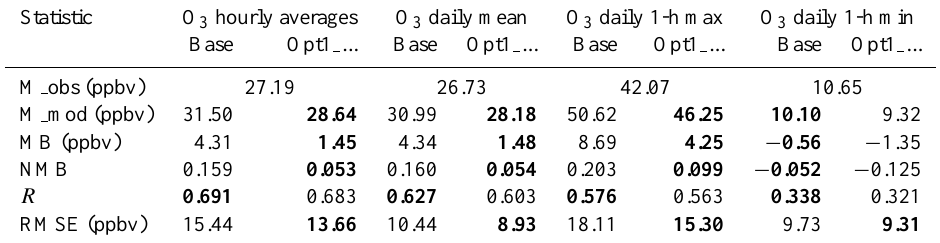
Ozone statistics for 23 surface ozone monitoring network sites in Alberta, summer 2002, comparing Base Case and Opt1 Dyn Extrap2 Wosp, 12km grid spacing domain. The run with the better value is shown in bold face, for each metric. M obs: mean observed value, M mod: mean model value, MB: mean bias, NMB: normalized mean bias, R : correlation coefficient, RMSE: Root Mean Square